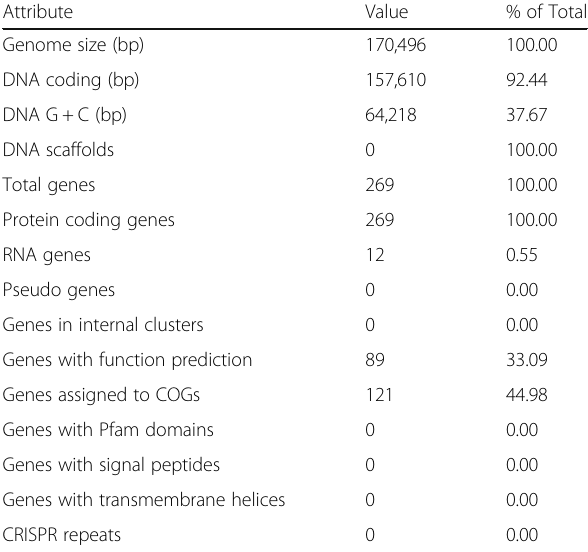
Table 3 Genome statistics